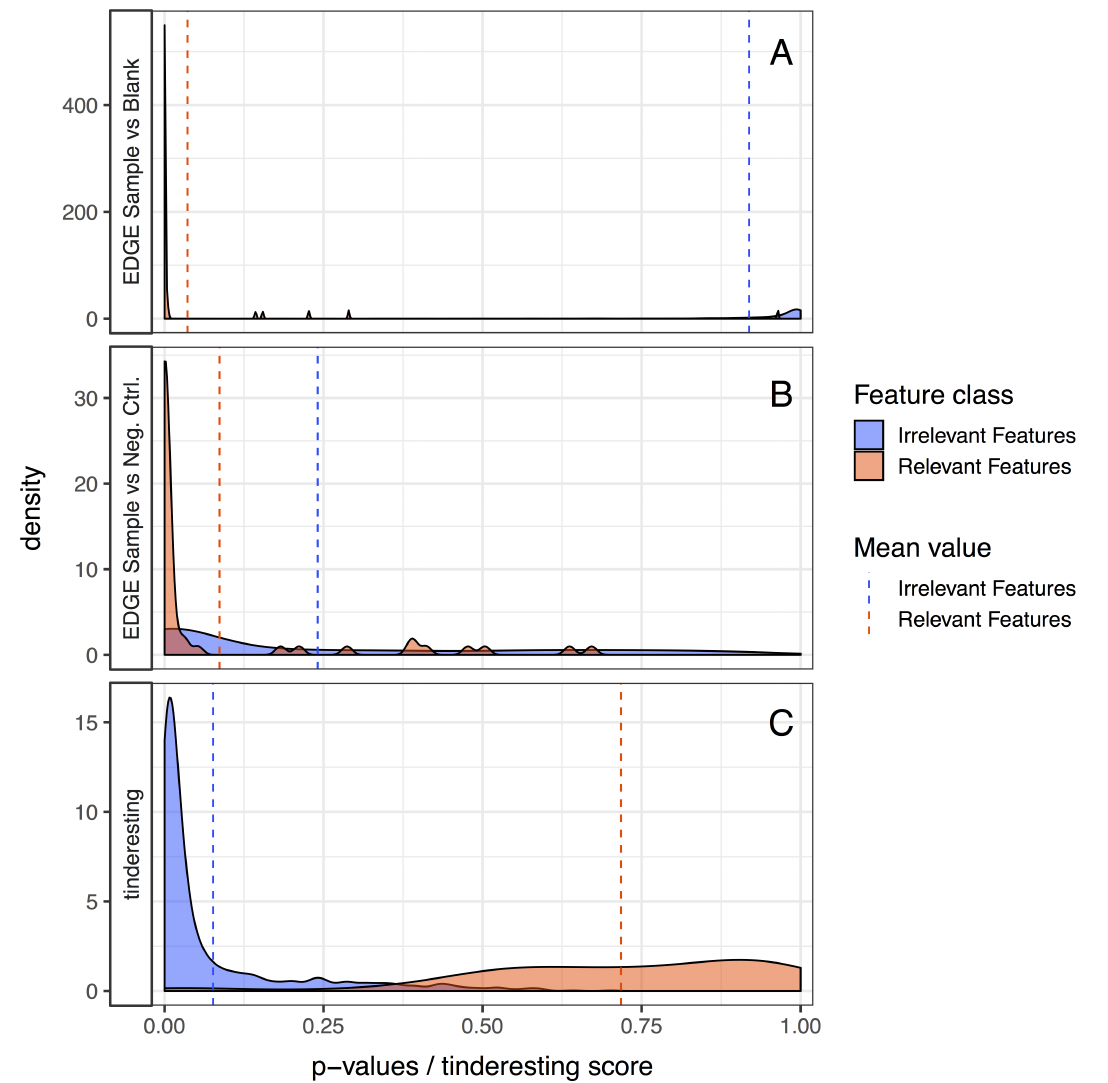
Figure 9. EDGE vs. tinderesting, comparing densities: ( A ) uncorrected EDGE p -values of sample vs. blank; ( B ) uncorrected EDGE p -values of sample vs. negative control; and ( C ) tinderesting